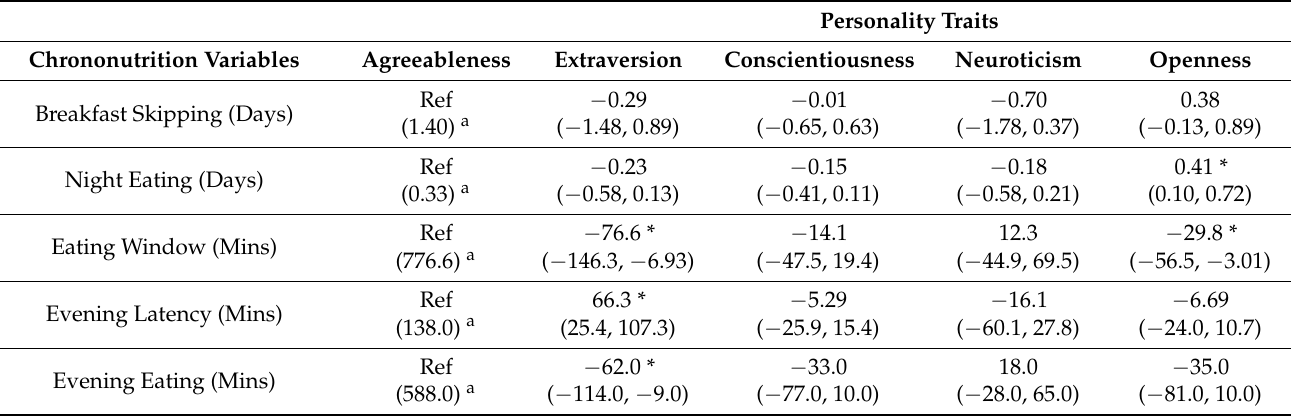
Table 3. Mean differences (95% confidence intervals) for the association between numeric chrononu- trition outcomes and personality traits during the COVID-19 lockdown, assessed by linear regression.